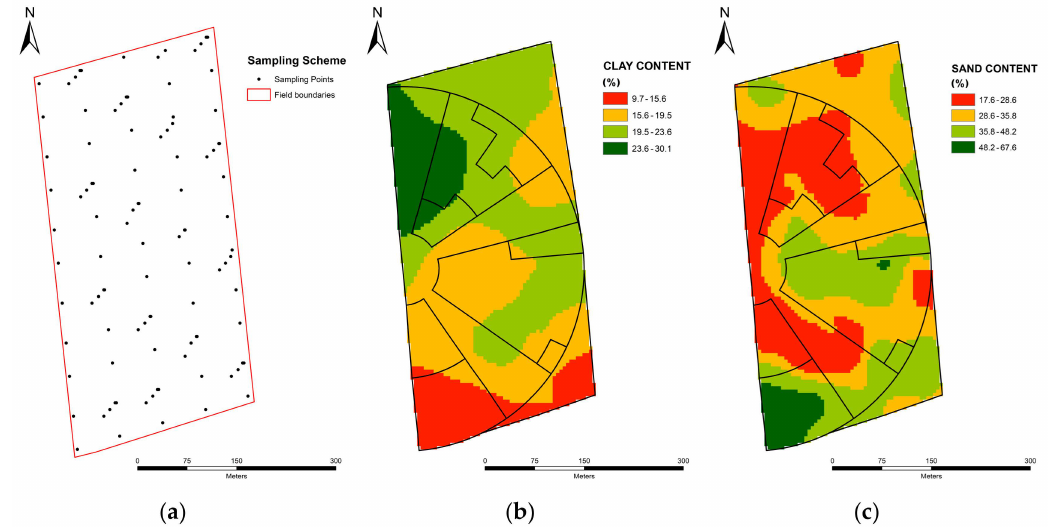
Figure 2. Soil sampling scheme utilized for the determination of soil texture with the 103 sampling points ( a ), clay content (expressed as percentage, %; b ) and sand (expressed as percentage, %; c ) content maps resulting from ordinary kriging. Modified from